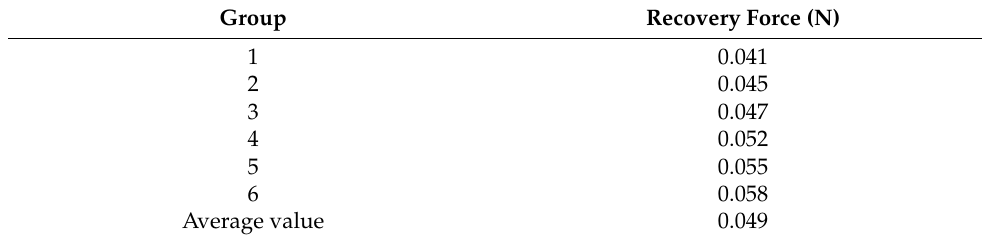
Table 5. Measurement data for the recovery